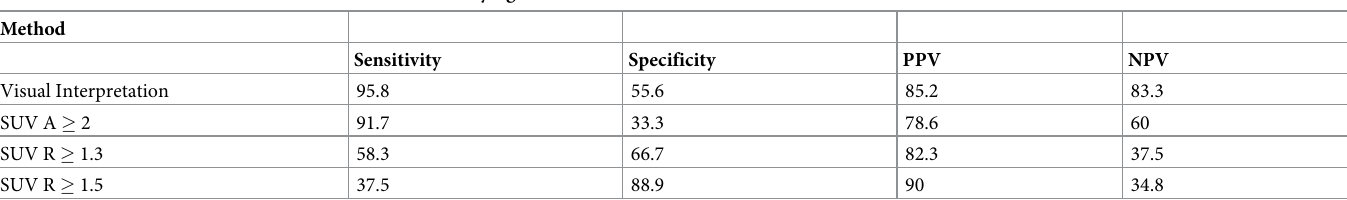
Table 3. Value of 18 F-Fluoro-L-DOPA PET scan in identifying focal.